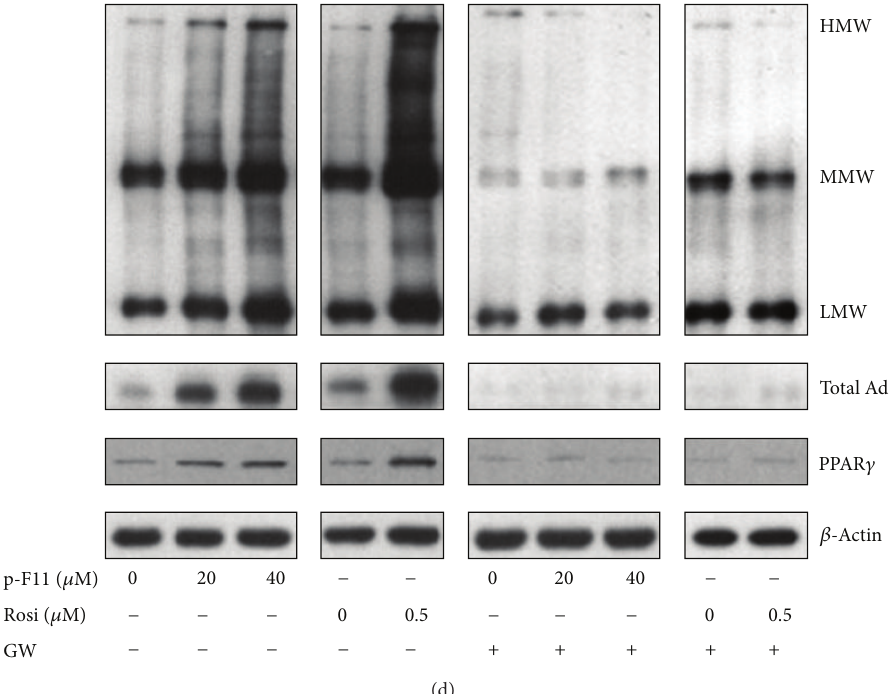
Figure 1: p-F11 promotes preadipocyte differentiation by activating PPAR 𝛾 . 3T3-L1 preadipocytes were induced to differentiate with 0, 20, 40 𝜇 MPseudoginsenosideF11(p-F11)or0.5 𝜇 Mrosiglitazone(Rosi)intheabsenceorpresenceof20 𝜇 MGW9662for8days. (a)Thecellswere stained with Oil Red O. Quantification of the staining results was presented in (b). Results (mean ± SD, 𝑛 = 3 ) were expressed as a percentage of the control (p-F11 0 𝜇 M). ∗ 𝑃 < 0.05 ; ∗∗ 𝑃 < 0.01 . (c) The mRNA level of adiponectin and PPAR 𝛾 was examined by quantitative real-time PCR. The results were expressed relative to 𝛽 -actin and presented as a percentage of the control. (d) The cell lysates were subjected to 2%–15% gradient gel electrophoresis under nonreducing and non-heat-denaturing conditions to detect the three oligomeric forms of adiponectin (LMW, MMW, and HMW) (top panel). The amount of total adiponectin (Total Ad), PPAR 𝛾 , or actin was detected with antibodies against the N-terminal peptide of adiponectin, PPAR 𝛾 , or 𝛽 -actin,